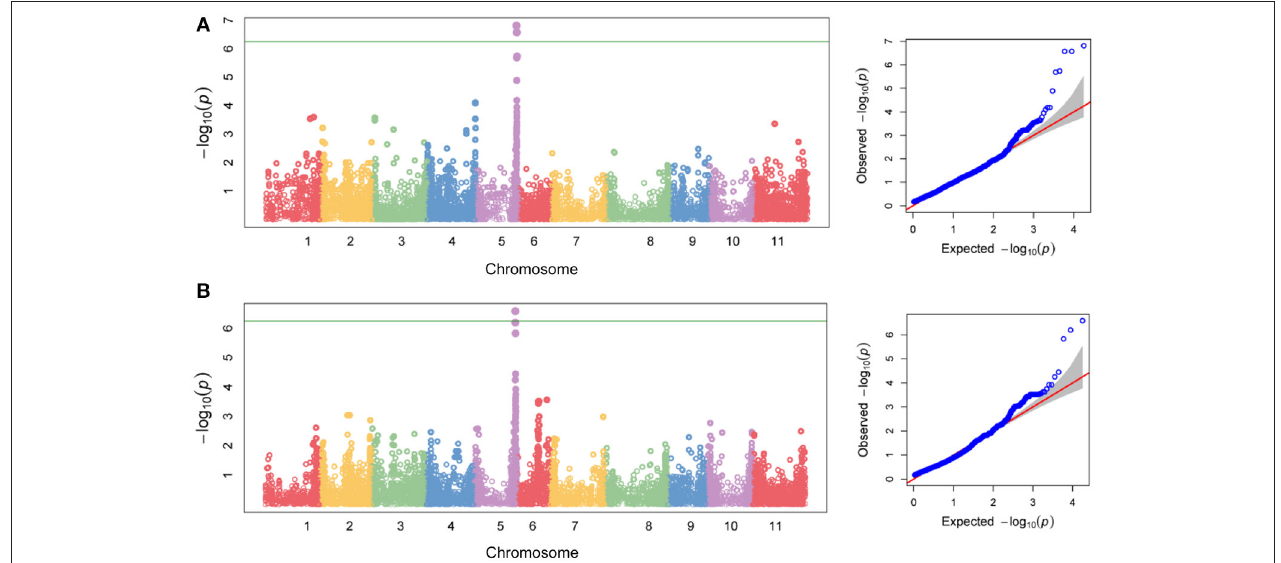
FIGURE 9 | Genome-wide association mapping detects markers on Pv05 associated with field resistance to Race 6 of Pseudomonas syringae pv. phaseolicola in an Andean Diversity Panel of Phaseolus vulgaris . Chromosomal distribution of − log 10 ( P ) values for 17,759 SNP associations, and accompanying Q-Q plots for